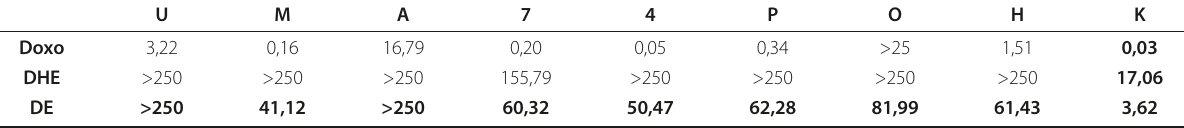
Table 4 Tumor growth inhibition (TGI) ( μ g/mL) induced by A. lappa extracts